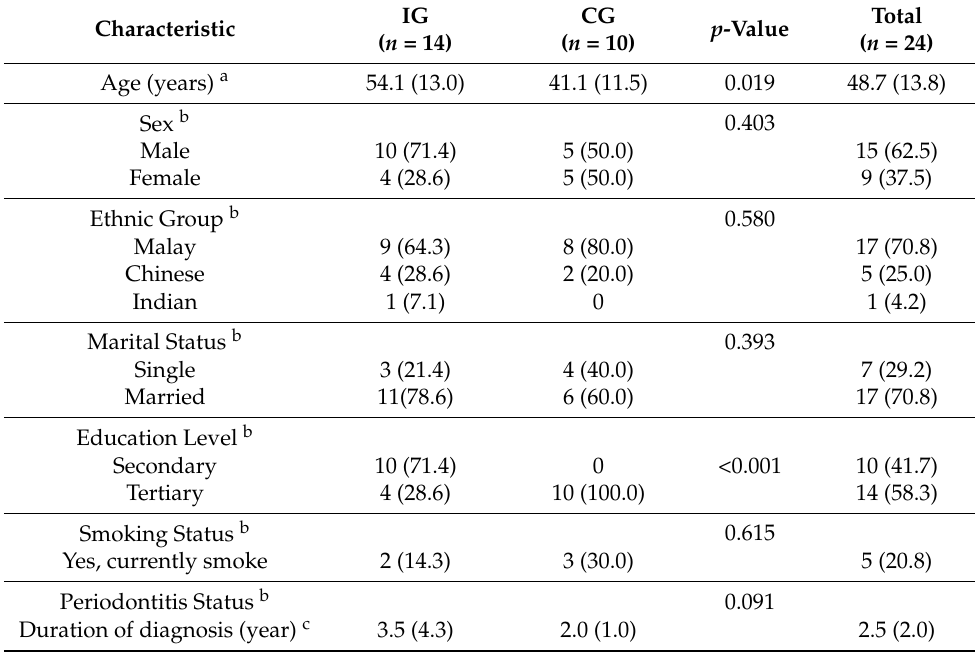
Table 1. Socio-demographic profiles of the participants.